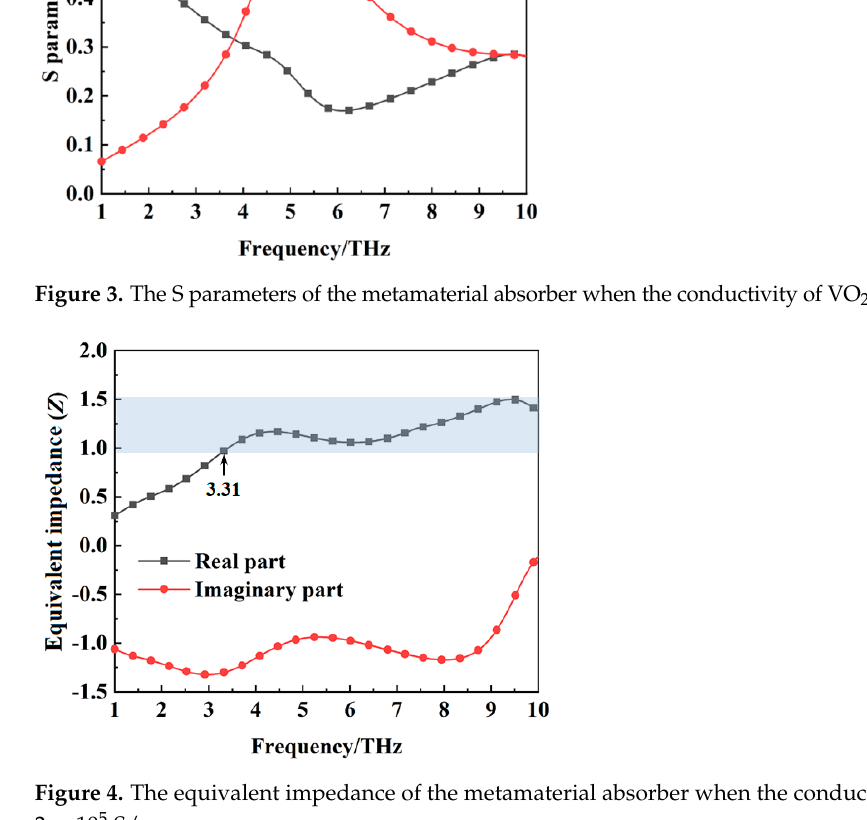
Figure 5. The equivalent impedance of the metamaterial absorber when the conductivity of VO 2 is 10 S/m. In order to further reveal the wideband absorption mechanism of the metamaterial absorber, we monitor the surface current distribution of the metamaterial absorber at 8 THz when the conductivity of VO 2 is 2 × 10 5 S/m, as shown in Figure 6. The surface cur- rents on the left and right sides of the top gold ring are parallel to the downward direction, which can alternately accumulate charge at the upper and lower part of the gold split ring and thus result in electric resonance [33]. The surface current on the outer sides of the split slot at the bottom layer acts in the opposite direction with the surface current of the front gold split ring, which forms a current circuit, and accordingly produces magnetic reso- nance [33]. The simultaneously produced electromagnetic resonance results in the high absorption of the incident waves. The loaded resistive film allows the metamaterial ab- sorber to function as a stable resonant circuit structure, and so its impedance matches well with the free space at a wide range near the resonant frequency and finally leads to the wideband absorption of the incident waves [34].